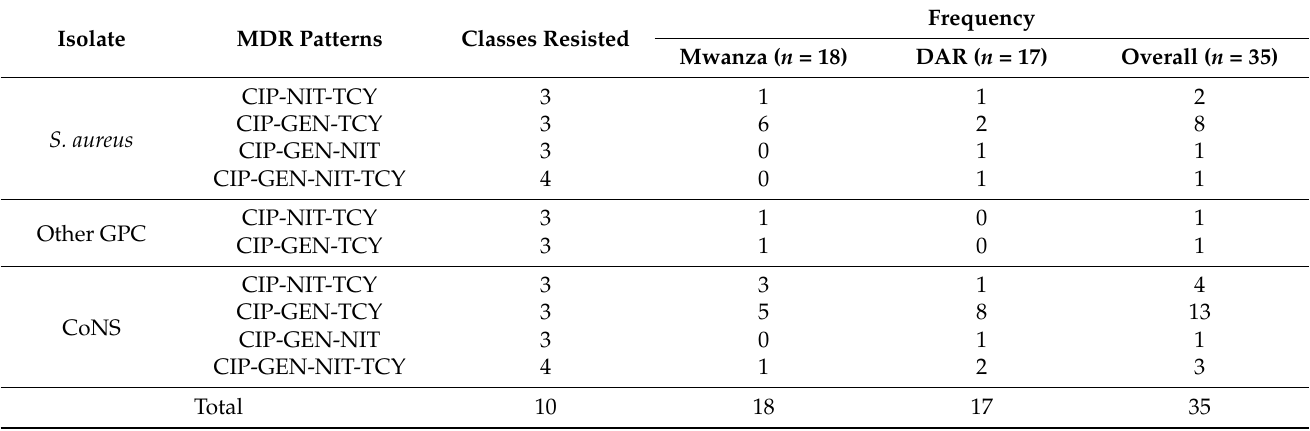
Table 6. Patterns of MDR bacteria among Gram-positive uropathogens causing community-acquired urinary tract infections in